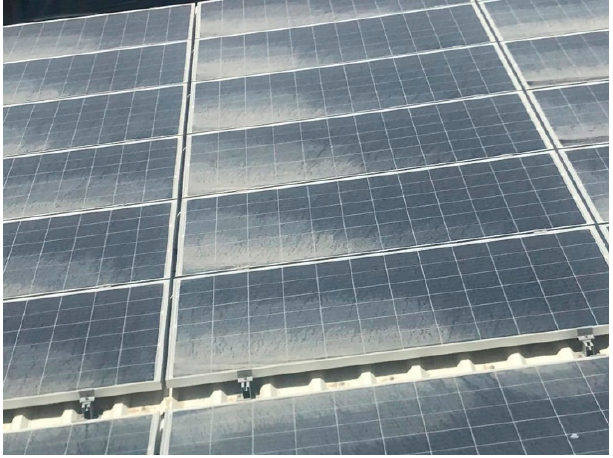
Figure 9. Photograph of partial section of the modules showing the high dust accumulation.